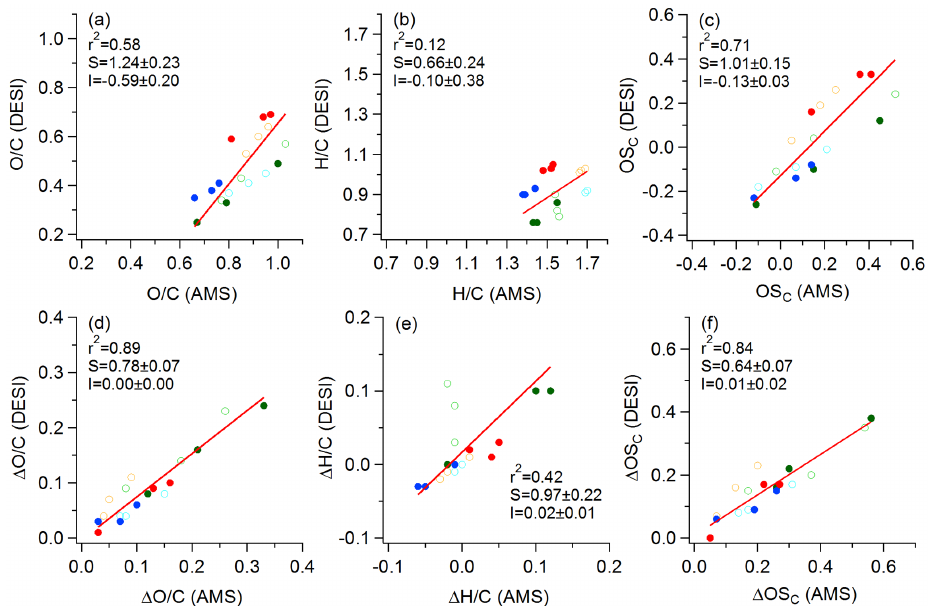
Figure A1. Scatter plots that compare nano-DESI MS and AMS measurements of the average (a) O / C, (b) H / C, and (c) OS C of aqSOA formed during three different stages of photoreaction and (d) (cid:49) O / C, (e) (cid:49) H / C, and (f) (cid:49) OS C between different stages. The (cid:49) denotes the difference between different reaction stages (i.e., P2-P1, P3-P2, P3-P1). All linear regressions were performed using orthogonal distance regression (ODR) and the slopes ( S ), intercepts ( I ), and correlation coefficients ( r 2 ) are shown in the legends. Different experimental conditions are represented by the symbols shown in the legend. The O / C, H / C, and OS C values shown here are also summarized